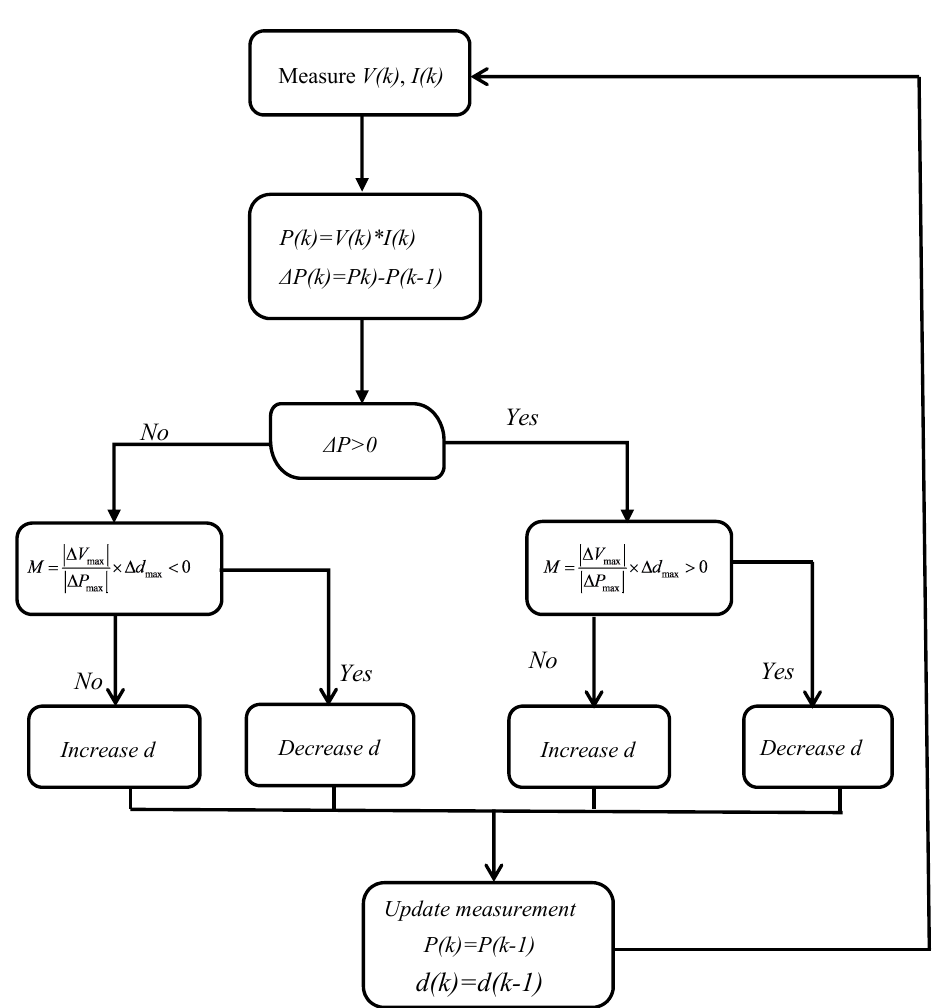
Figure 6. Flowchart of perturb and observe (P&O) algorithm.